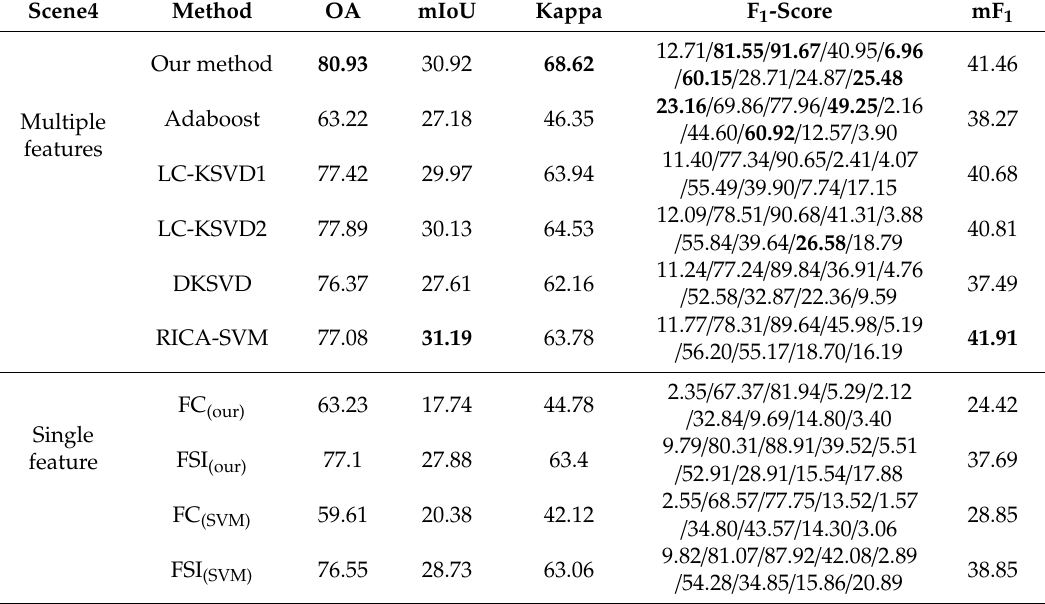
Table 6. Classification results of Scene4 (%). F 1 -score corresponds to the accuracy in terms of poles / buildings / trees / street lights / pedestrians / cars / wires / towers / tra ffi c signs. Note that the highest accuracy values are highlighted in